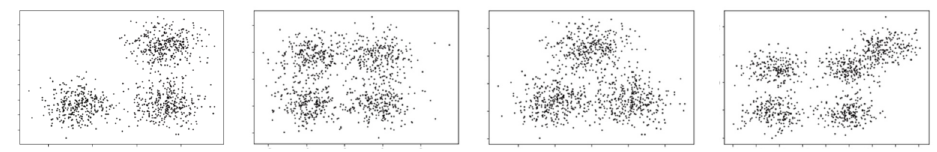
Figure 1. Dataset points in 2D spatial